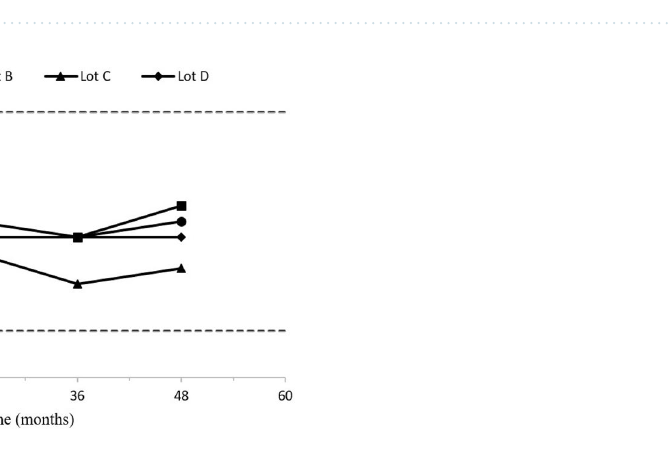
Figure 5. Acid or base summary of the buffering capacity of the second sulfatase and BSA at different protein concentrations.